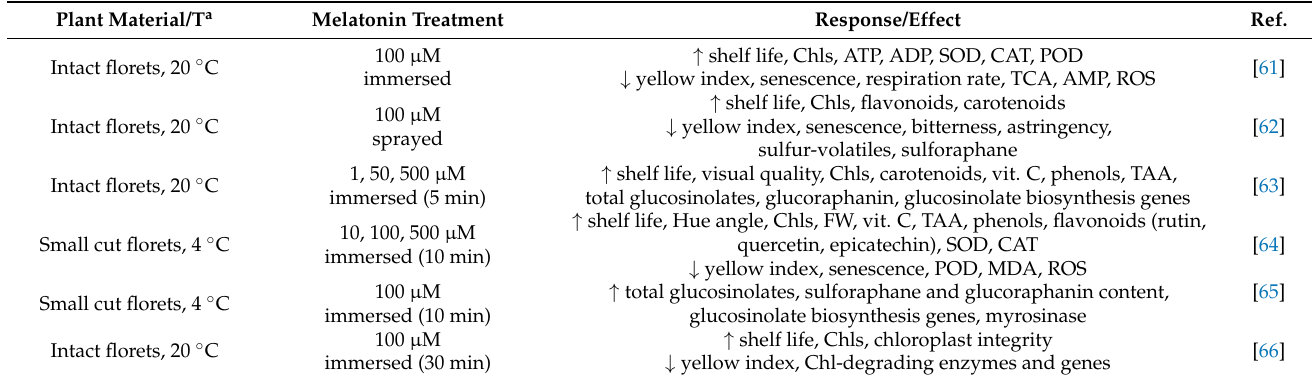
Table 2. Studies on melatonin application in broccoli ( B. oleracea var. italica ) heads/florets. Plant Material/T a Melatonin Treatment Response/Effect